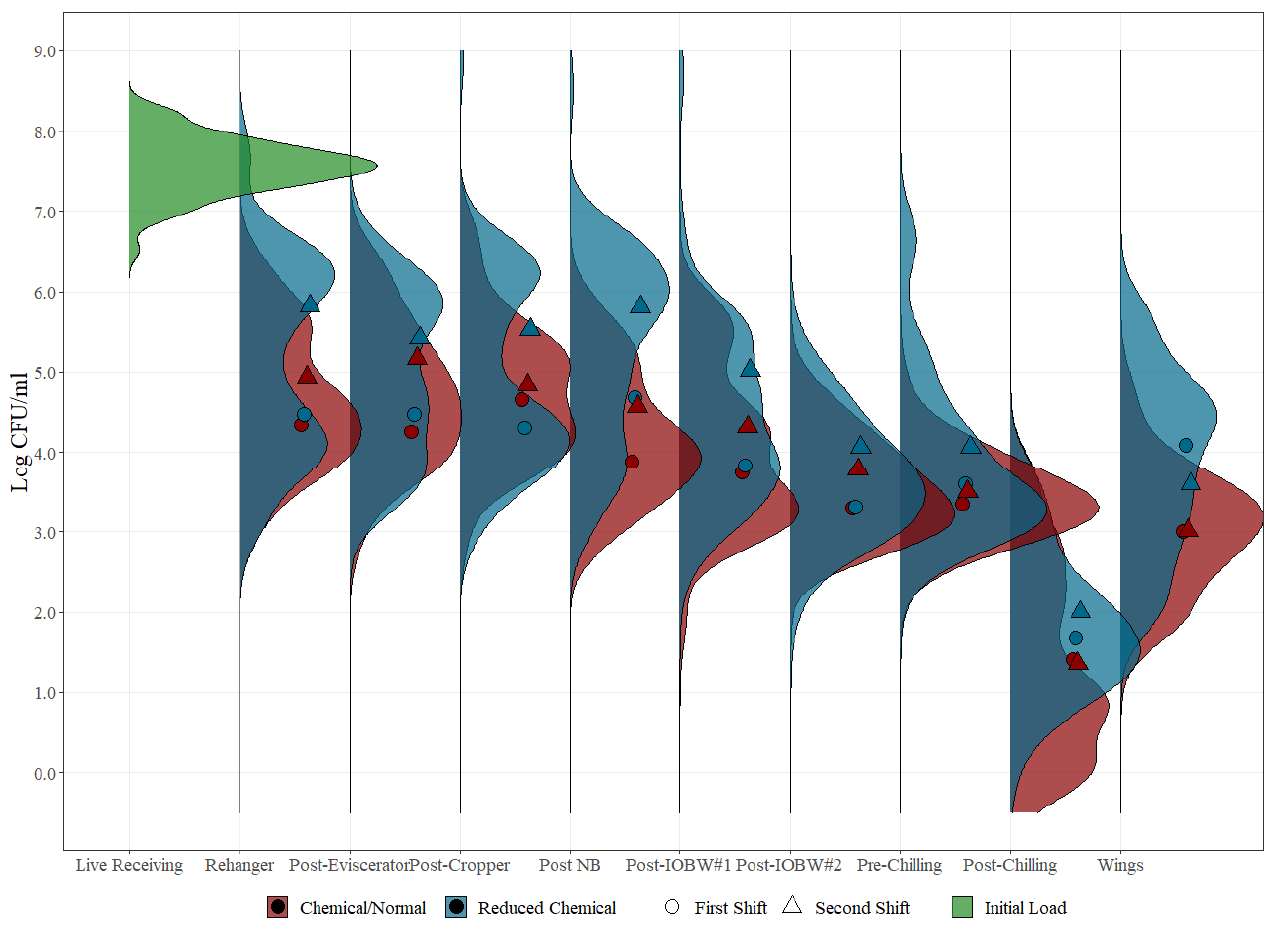
Figure 4. Kernel density estimation for mesophilic aerobic counts (Log CFU/mL) on each of the ten sampling locations evaluated under normal process interventions (red) and reduced chemical process (blue) intervention schemes on whole carcass chicken and part rinses. The dots represent the average value for mesophilic aerobic counts on each sampling location under both process interventions (normal and reduced) during different shifts (circle vs. triangle).